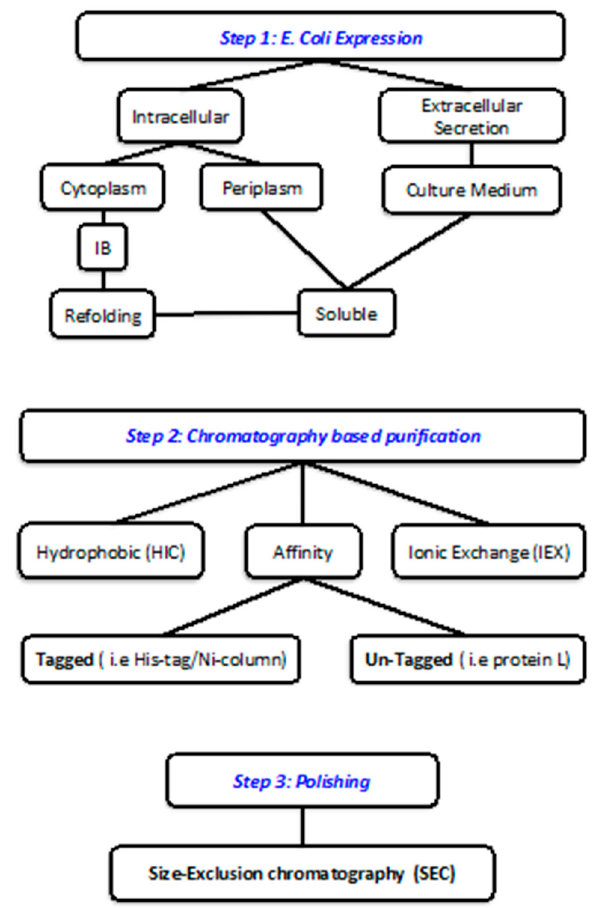
Figure 2. Three step procedure for obtaining purified recombinant antibody fragments following the expression in E. coli